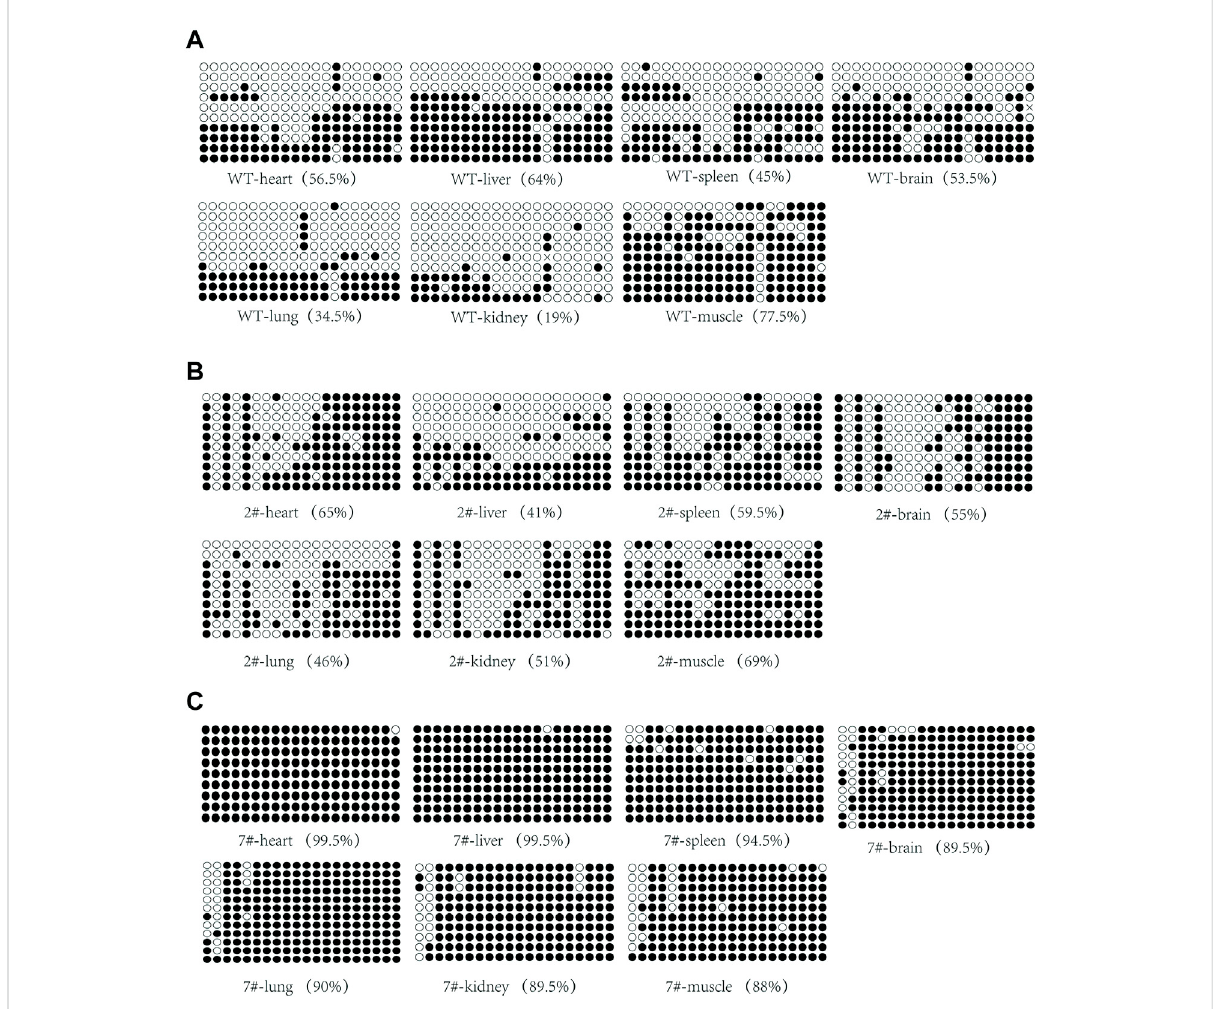
FIGURE 5 Analysis of IG-DMR methylation in wild-type neonatal pigs and cloned neonatal pigs. (A) Analysis of IG-DMR methylation in wild-type neonatal pigs. (B) Analysis of methylation in the surviving cloned piglet #2. (C) Analysis of methylation in dead cloned piglet #7. Each circle represents a CpG dinucleotide. The degree of methylation (%) is based on methylated CpGs/all CpGs; open circles indicate unmethylated CpGs, and fi lled circles indicate methylated